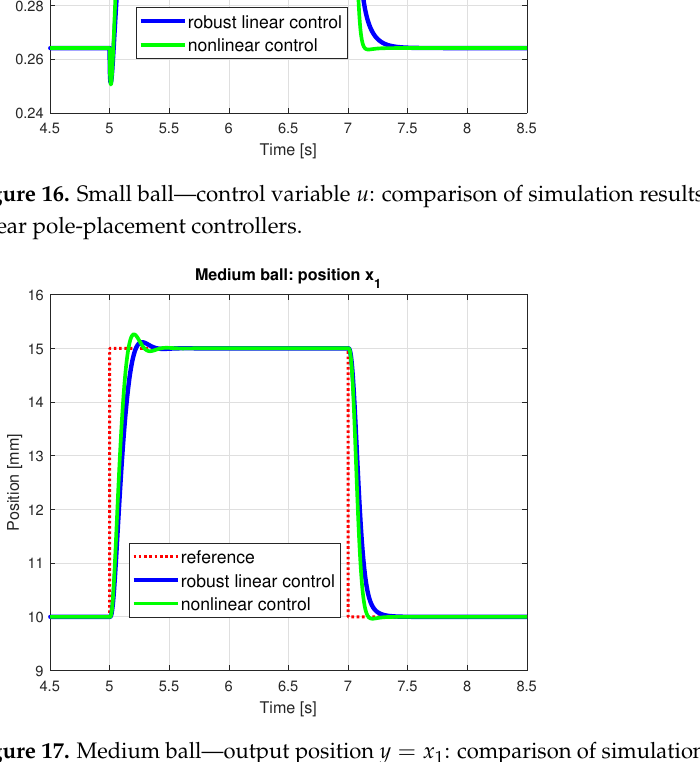
Figure 17. Medium ball—output position y = x 1 : comparison of simulation results for nonlinear and robust linear pole-placement controllers.